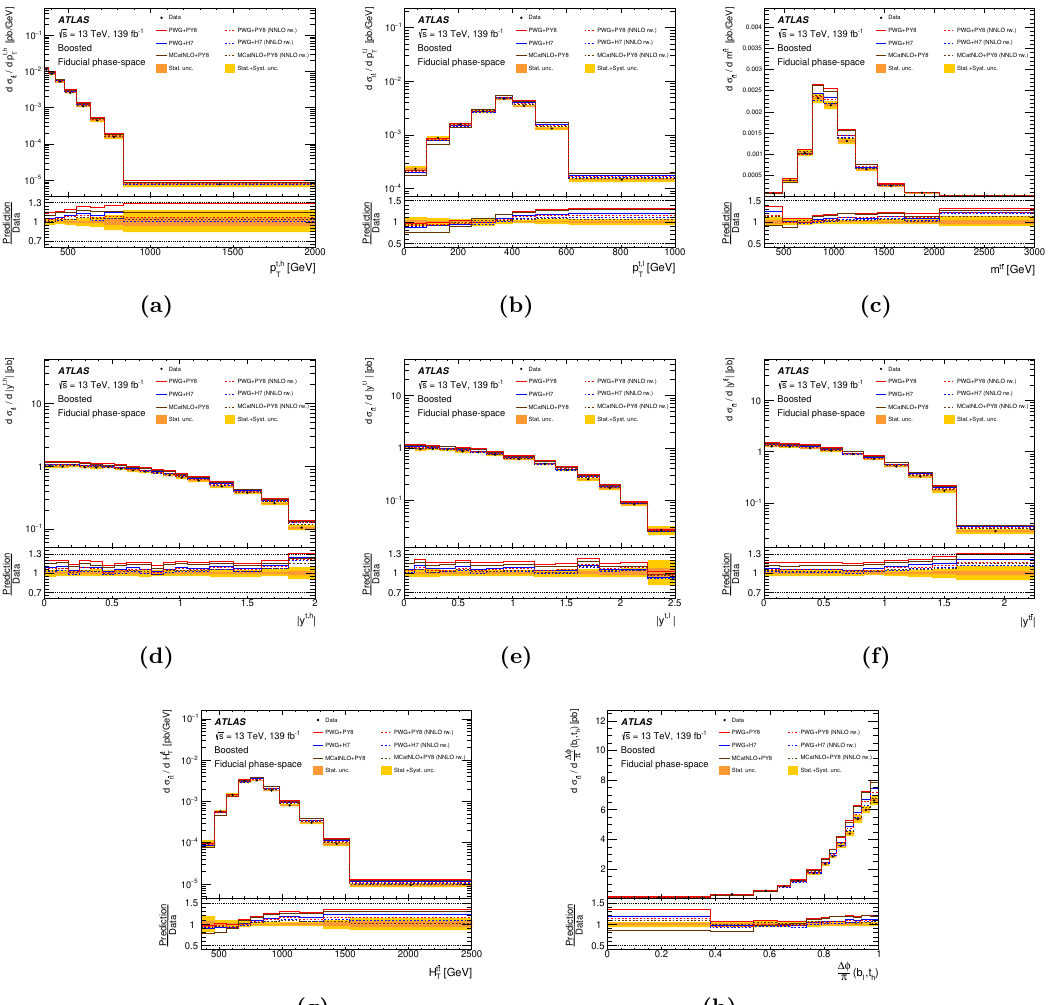
Figure 11. Differential cross-section measurements for the observables related to the kinematics of the top quarks. The cross-section is shown as a function of (a) p t,h , (b) p t,‘ , (c) m t ¯ t , (d) | y t,h | , T T (e) | y t,‘ | , (f) | y t ¯ t | , (g) H t ¯ t and (h) ∆ φ ( b ) . In each plot the data are compared with predictions , t ‘ h T from the NLO generators with and without the NNLO reweighting. PWG+PY8 corresponds to the Powheg+Pythia sample, PWG+H7 to the Powheg+Herwig sample and MCatNLO+PY8 to the MadGraph5_aMC@NLO+Pythia sample. The orange band shows the size of the statistical uncertainty and the yellow band shows the size of the total uncertainty. The lower panel in each subfigure displays the ratios of the different predictions to the